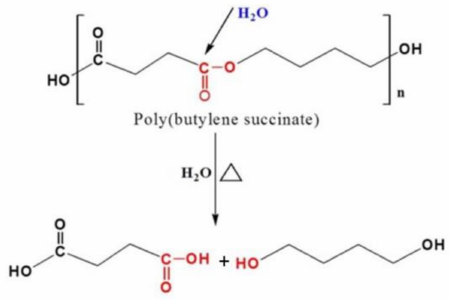
Figure 1. PBS hydrolysis